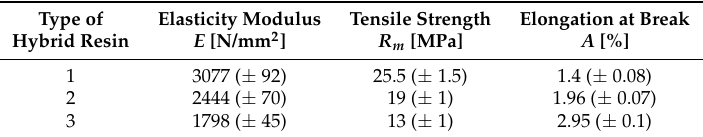
Table 2. The mean value with the standard deviation for elasticity modulus, tensile strength and elongation at break for samples of the 3 types of hybrid resin.